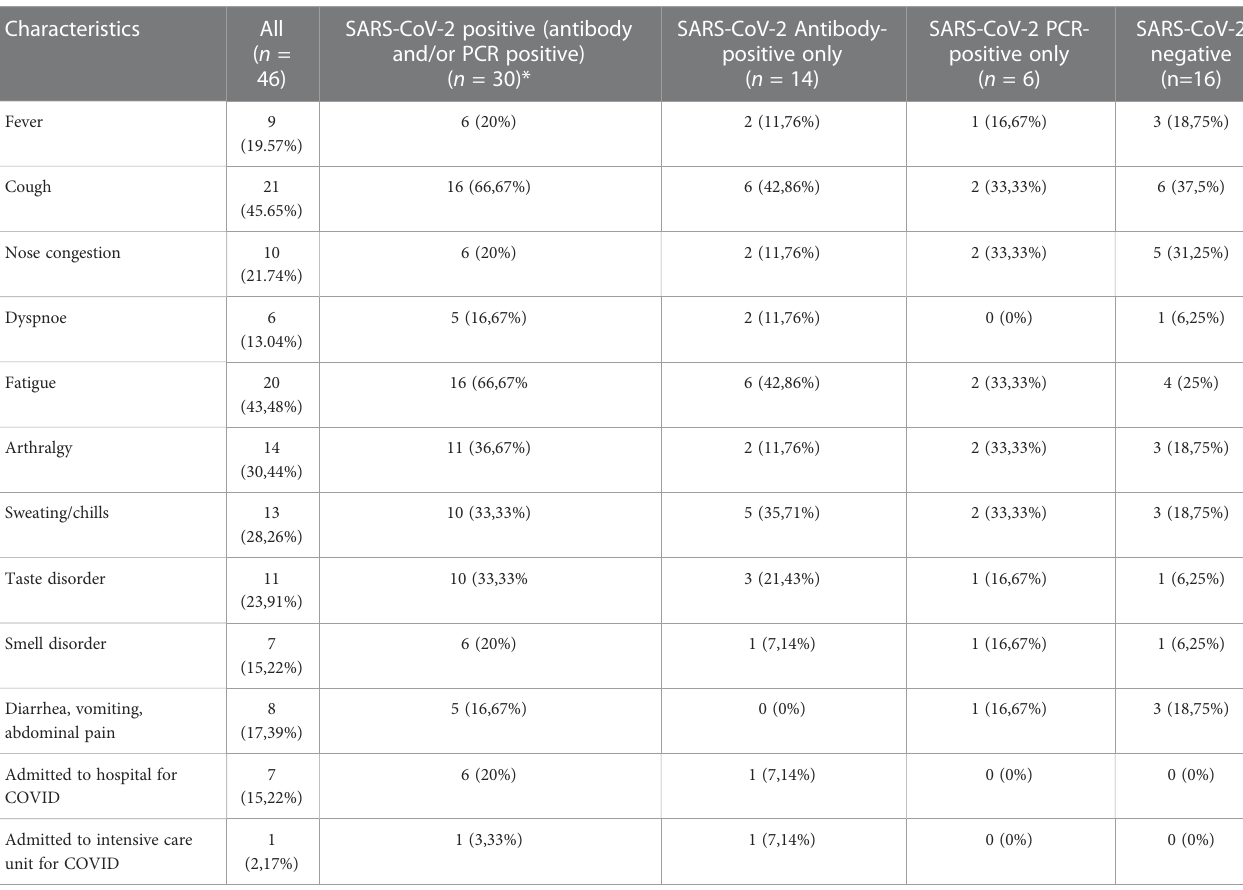
= 0.31; SD EDI = 0.11 vs. mean EU = 0.21; SD EU = 0.12; t -test p < 0.001) (Supplementary Figure S2A). For the early time points, this was con fi rmed in the comparison of the EDI test with the Diasorin (S1/S2) test (mean DS = 0.65; SD EDI = 0.46; t -test p = 0.05). Yet, after 12 0.76; SD EDI = 0.62; t -test p < 0.001). The data suggest a rapid